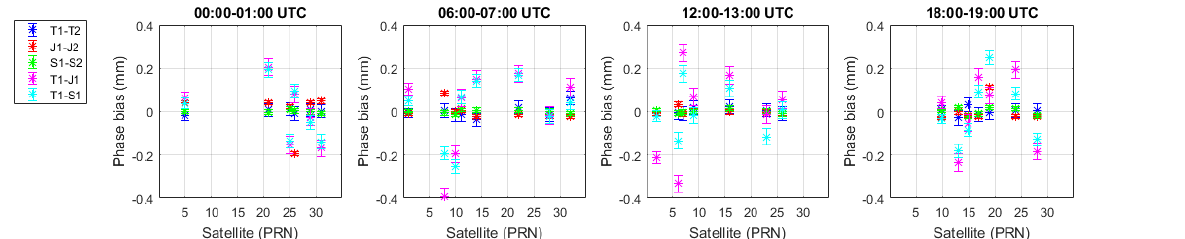
thereby available for analysis. The first part of this study will however be limited to L1C (carrier phase of L1 C/A code tracking). The later part analyzes civil and encrypted code on both L1 and L2. Both parts are delimited to GPS